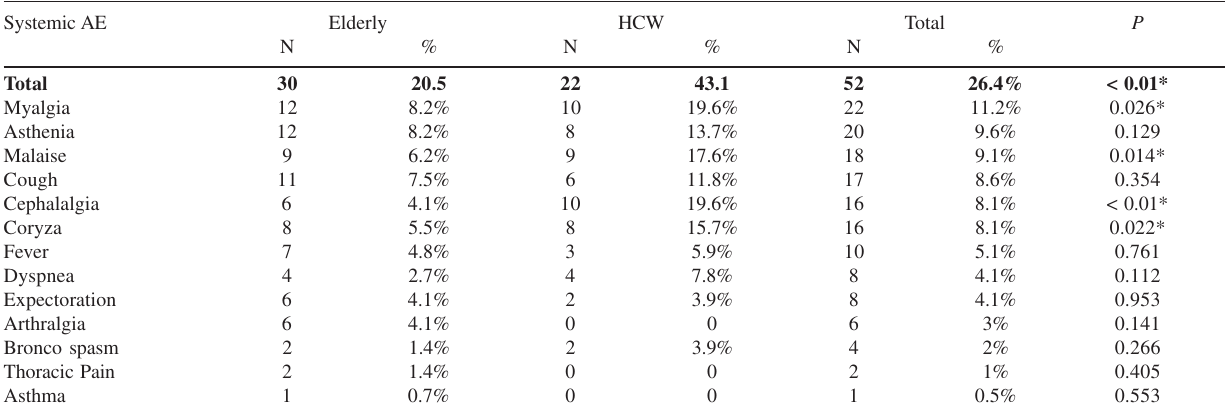
Table 4 - Occurrence of systemic adverse events after influenza vaccination. Hospital das Clínicas, São Paulo University Medical School. 2002 Systemic AE Elderly